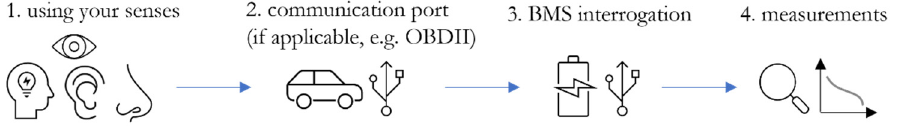
Figure 2. Options to obtain information relevant for battery state assessment with the sequence of consideration/execution.